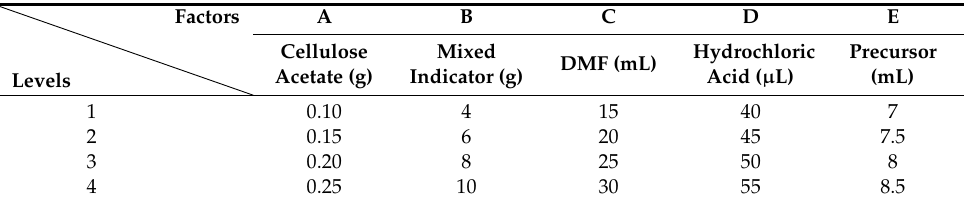
Table 1. The L 16 ( 4 5 ) factor level of the pH-sensitive membrane composition ratio. L factor level of the pH-sensitive membrane composition ratio. Table 1. the )4( 5 16